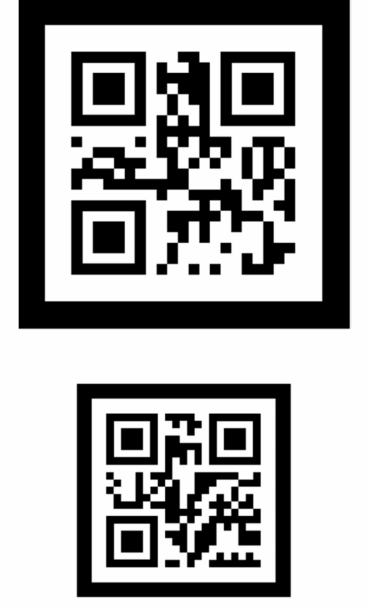
Figure 10. 2-D hierarchical